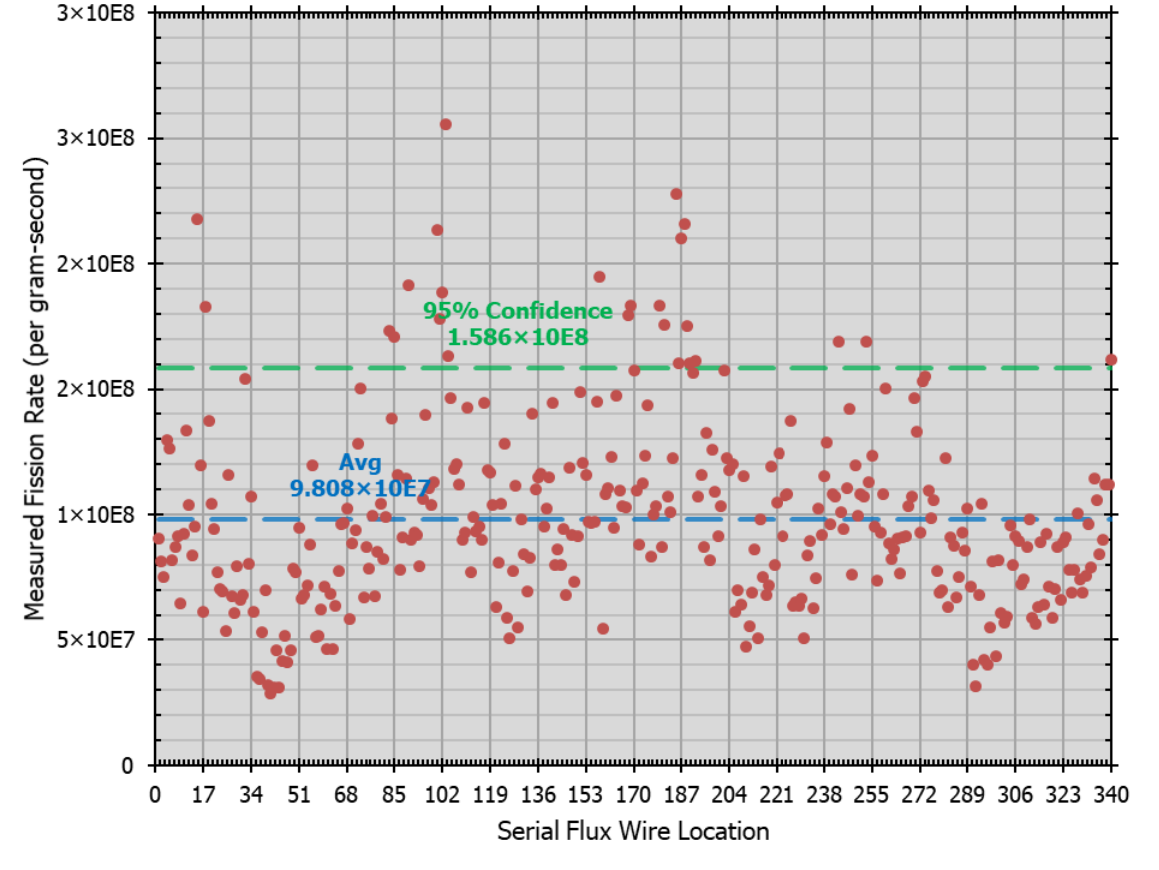
Figure 4. Standard Deviations of Fission Rate